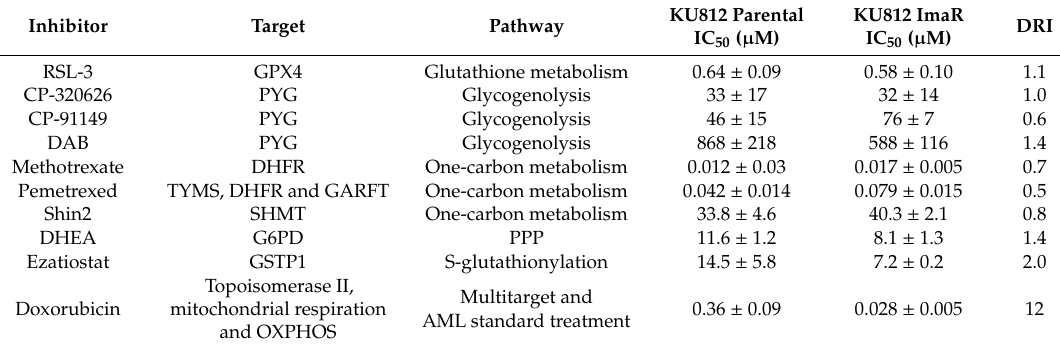
Table 1. The half-maximal inhibitory concentration (IC 50 ) values of KU812 Parental and ImaR cells upon inhibitor